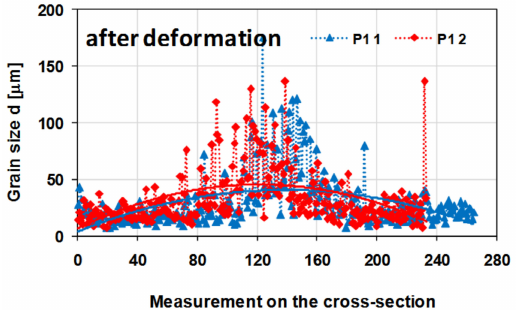
Figure 21. Changes in the grain size on the cross-section of a sample from the 5019 aluminium alloy after the deformation process; the measurements were made in two perpendicular directions (as shown in Figure 15); P1—material condition after hot